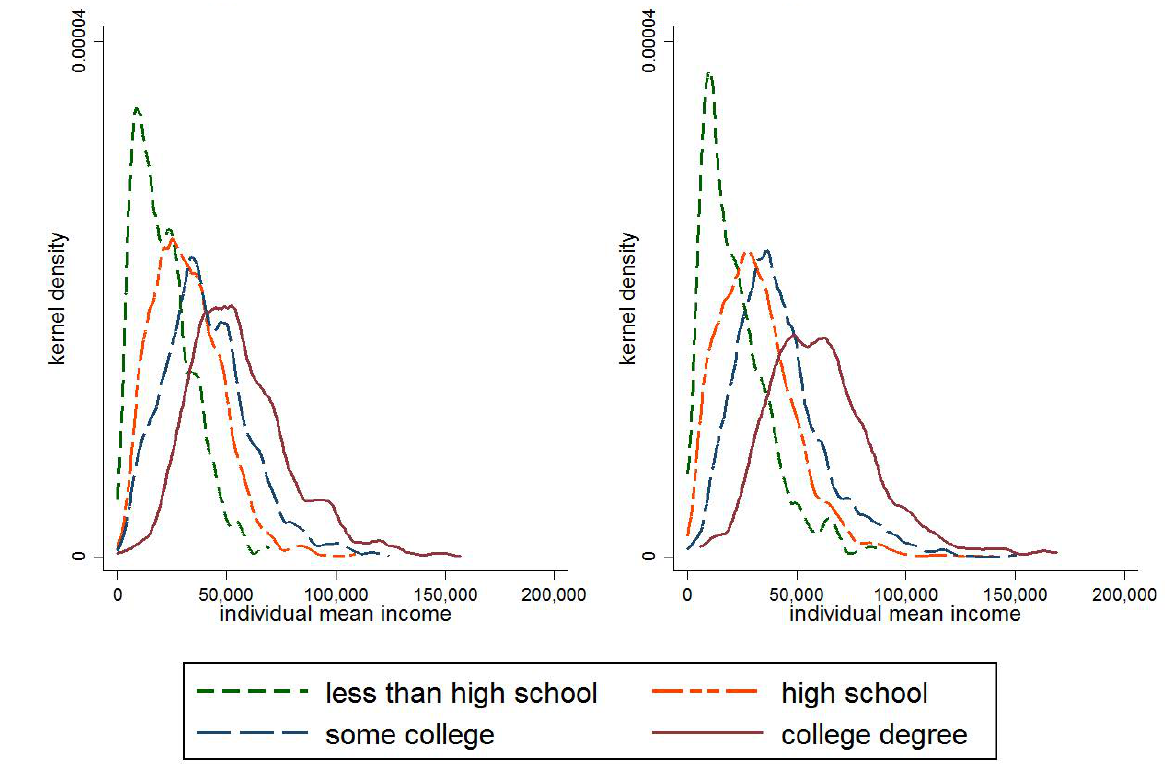
Figure 3: Densities of Income by